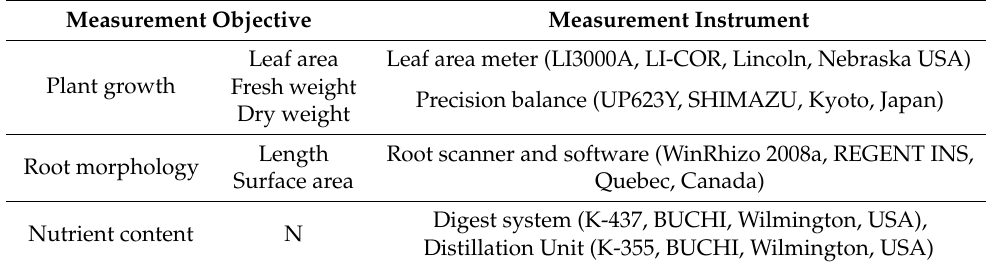
Table 2. Measurement objectives and instruments